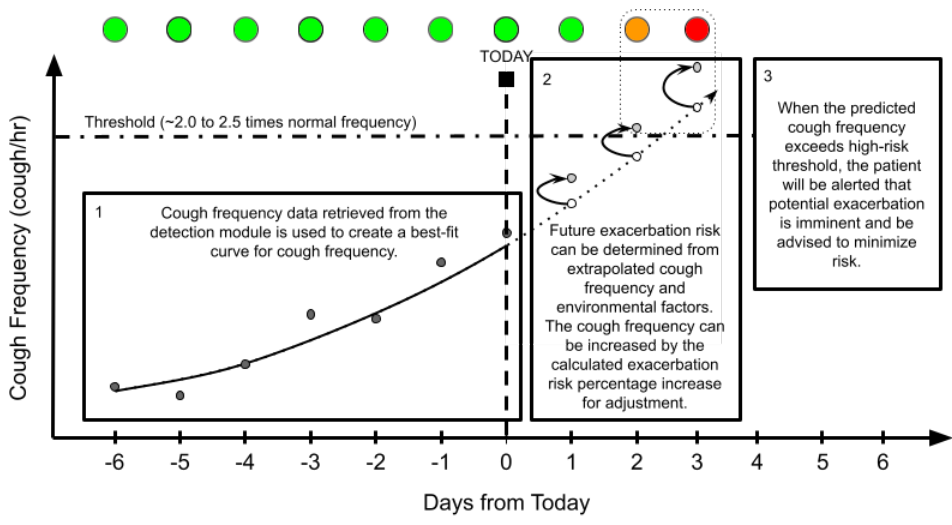
Figure 5. Illustration of the procedures implemented within the prediction module that forecasts the expected progression of the condition of the patient in the days ahead. This final step in the multi-modal architecture combines the results from the respiratory sound analysis performed by the machine learning model of the detection module, and the environmental and meteorological factors and trends analysis conducted by the environmental module. By extrapolating the cough frequency trends by taking cough frequencies in future days from a best-fit curve, along with the predicted exacerbation risks due to the environmental and meteorological data, the system can alert the patient and caregivers of the imminent risks and preempt medical interventions to potentially reduce hospitalization costs. A green circle represents a day where the adjusted cough frequency is lower than the threshold, orange represents a day when the adjusted frequency is higher than the threshold, and red represents a day when the original cough frequency exceeds the threshold. Orange and red are “danger”